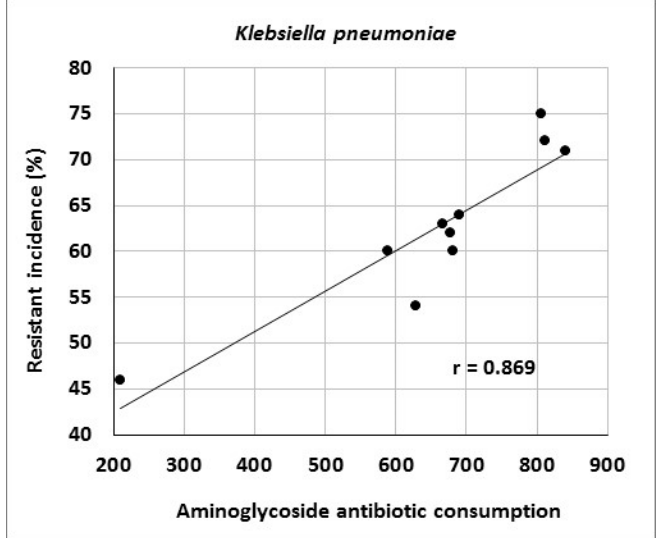
Figure 4. Correlation between aminoglycoside consumption (in numbers of defined daily doses) and resistance of Klebsiella pneumoniae to gentamicin.